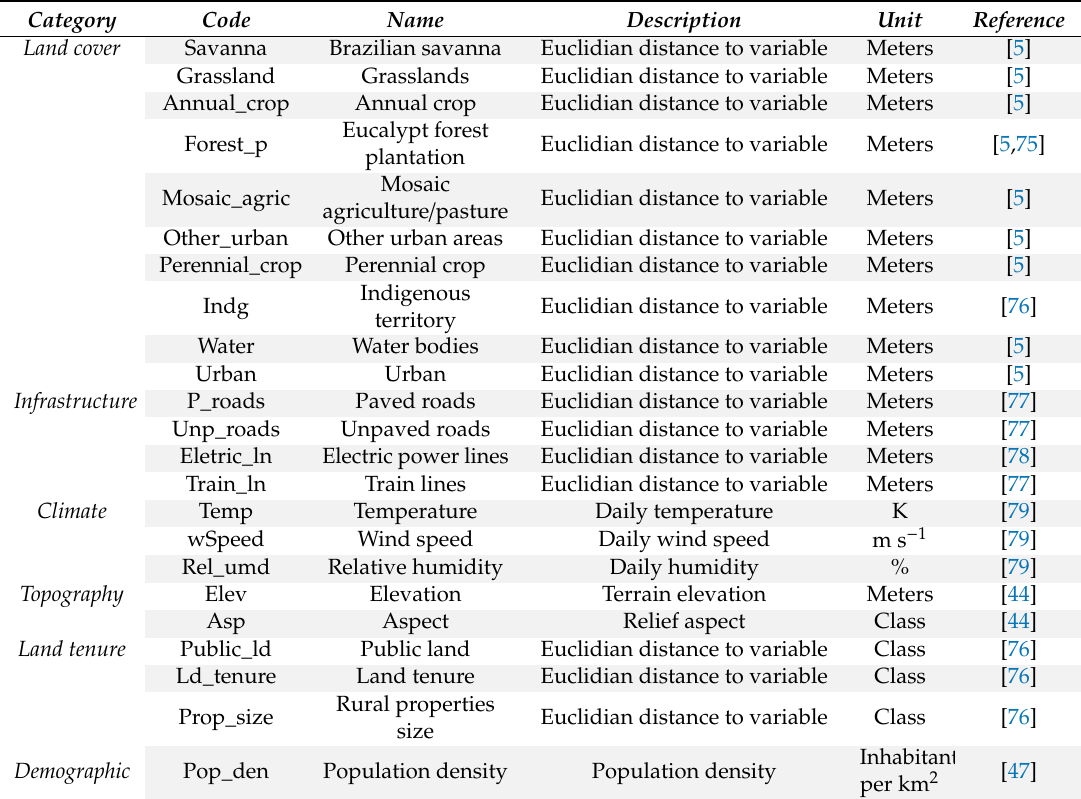
Table 1. Description of initial explanatory variables for modeling the wildfire occurrence